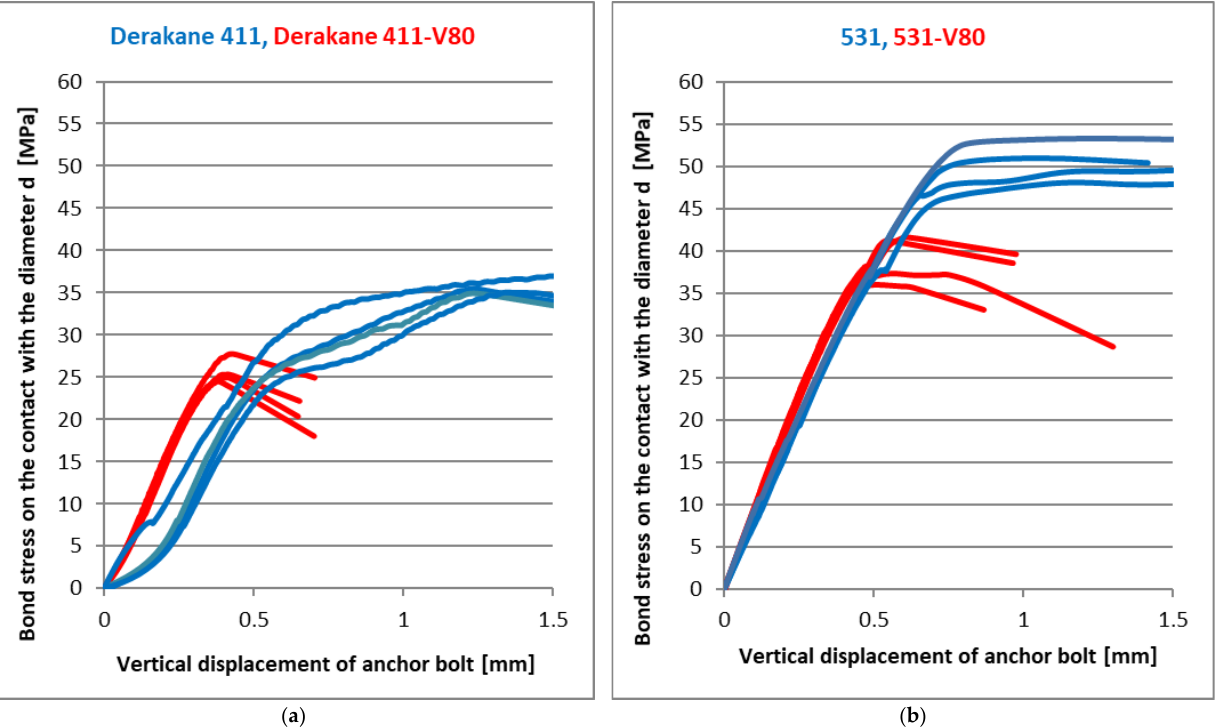
Figure 9. The effect of 80% of grounded limestone (V80) in the mixture: ( a ) Deracane 411; ( b ) CHS Epoxy 531 [9].